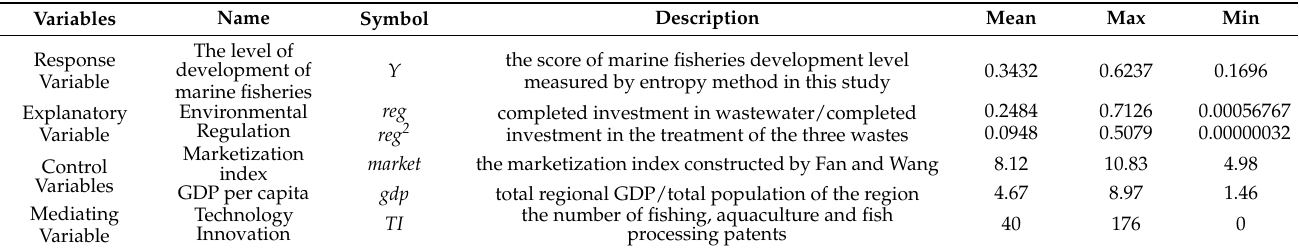
Table 3. Descriptive statistics.